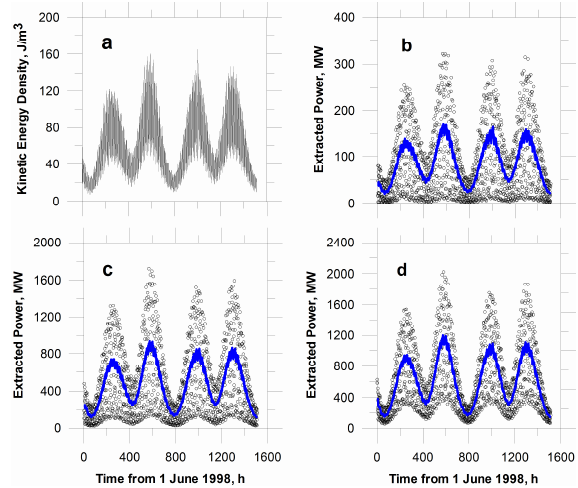
Fig.3. Time series of kinetic energy per unit volume averaged over the study area (a) 638 Fig. 3. Time series of kinetic energy per unit volume averaged and power loss from ocean currents due to tidal energy farm at different rates of 639 over the study area (a) and power loss from ocean currents due to energy extraction: (b) low, (c) medium, and (d) high rated capacity farm. Open circles 640 tidal energy farm at different rates of energy extraction: (b) low, show values of power extraction spatially integrated over the whole model domain, 641 (c) medium, and (d) high rated capacity farm. Open circles show solid curves show a running mean with a 12 hours averaging window. 642 values of power extraction spatially integrated over the whole model domain, solid curves show a running mean with a 12h averaging window.